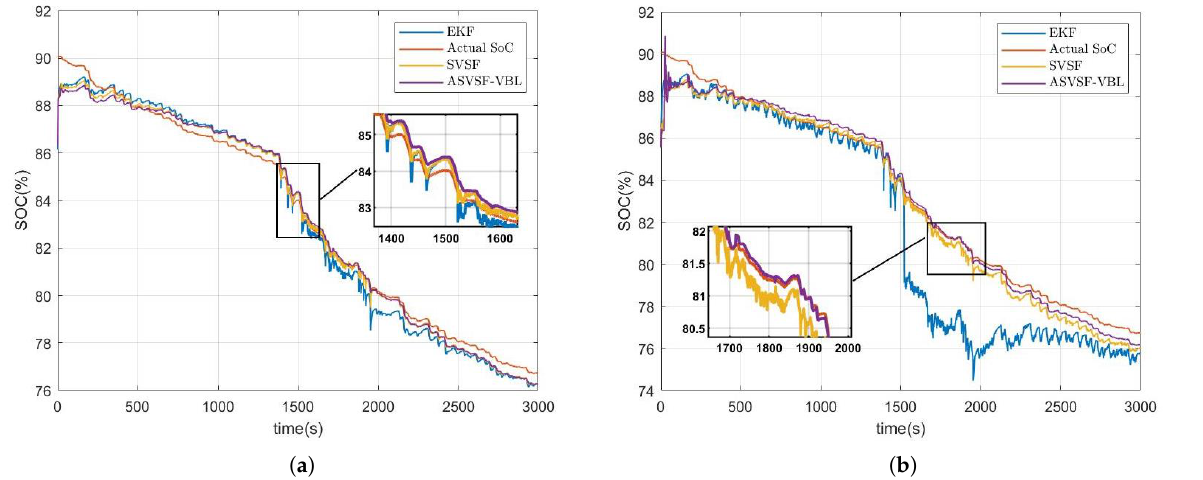
Figure 8. ( a ) Estimated SoC for an ideal scenario, ( b ) Estimated SoC in presence of noise and current bias.